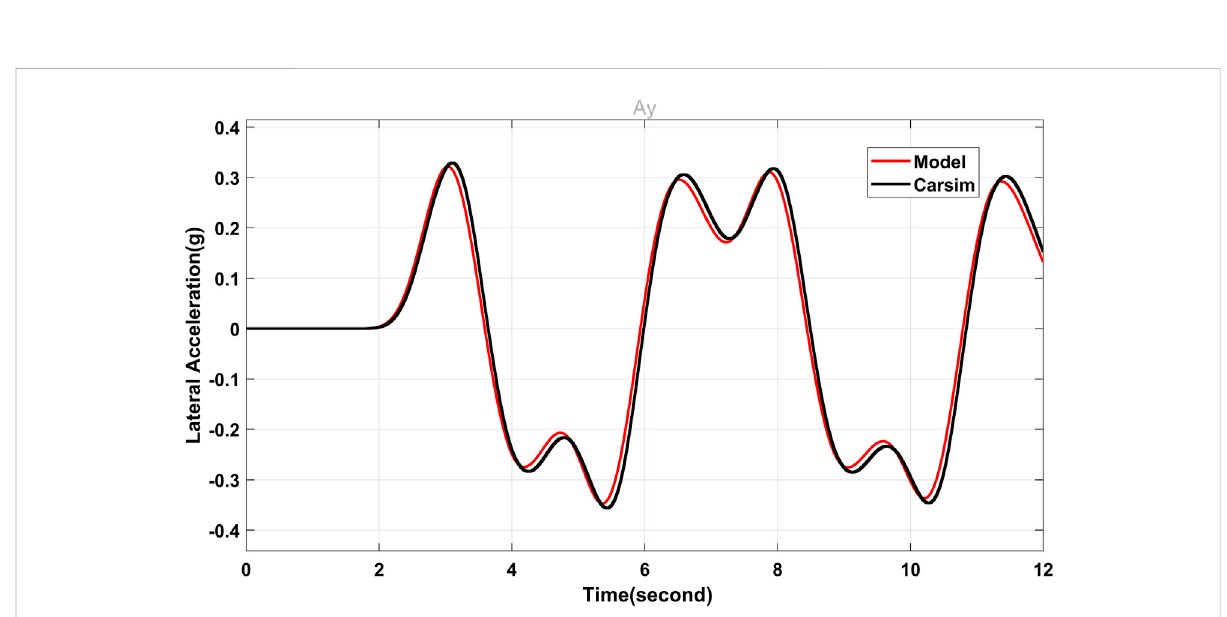
FIGURE 4 Comparison between the tricycle model that has been suggested and CarSim ’ s lateral